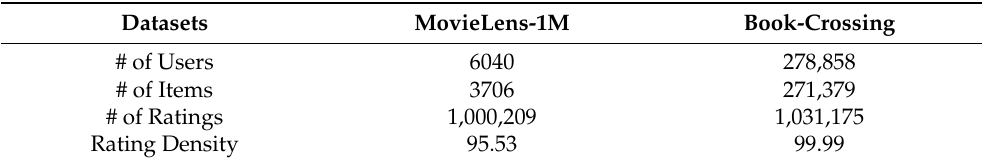
Table 1. Statistics of the